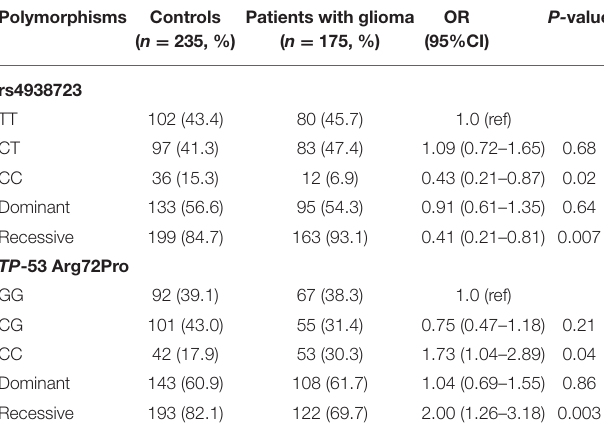
TABLE 2 | The genotype frequencies of miR-34b/c rs4938723 and TP-53 Arg72Proin glioma patients and controls. Polymorphisms Controls Patients with glioma ( n = 235, %) ( n = 175, %)